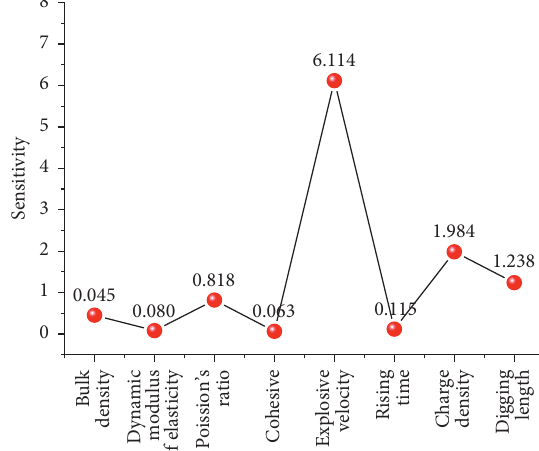
Figure 25: Sensitivity analysis of the right wall.